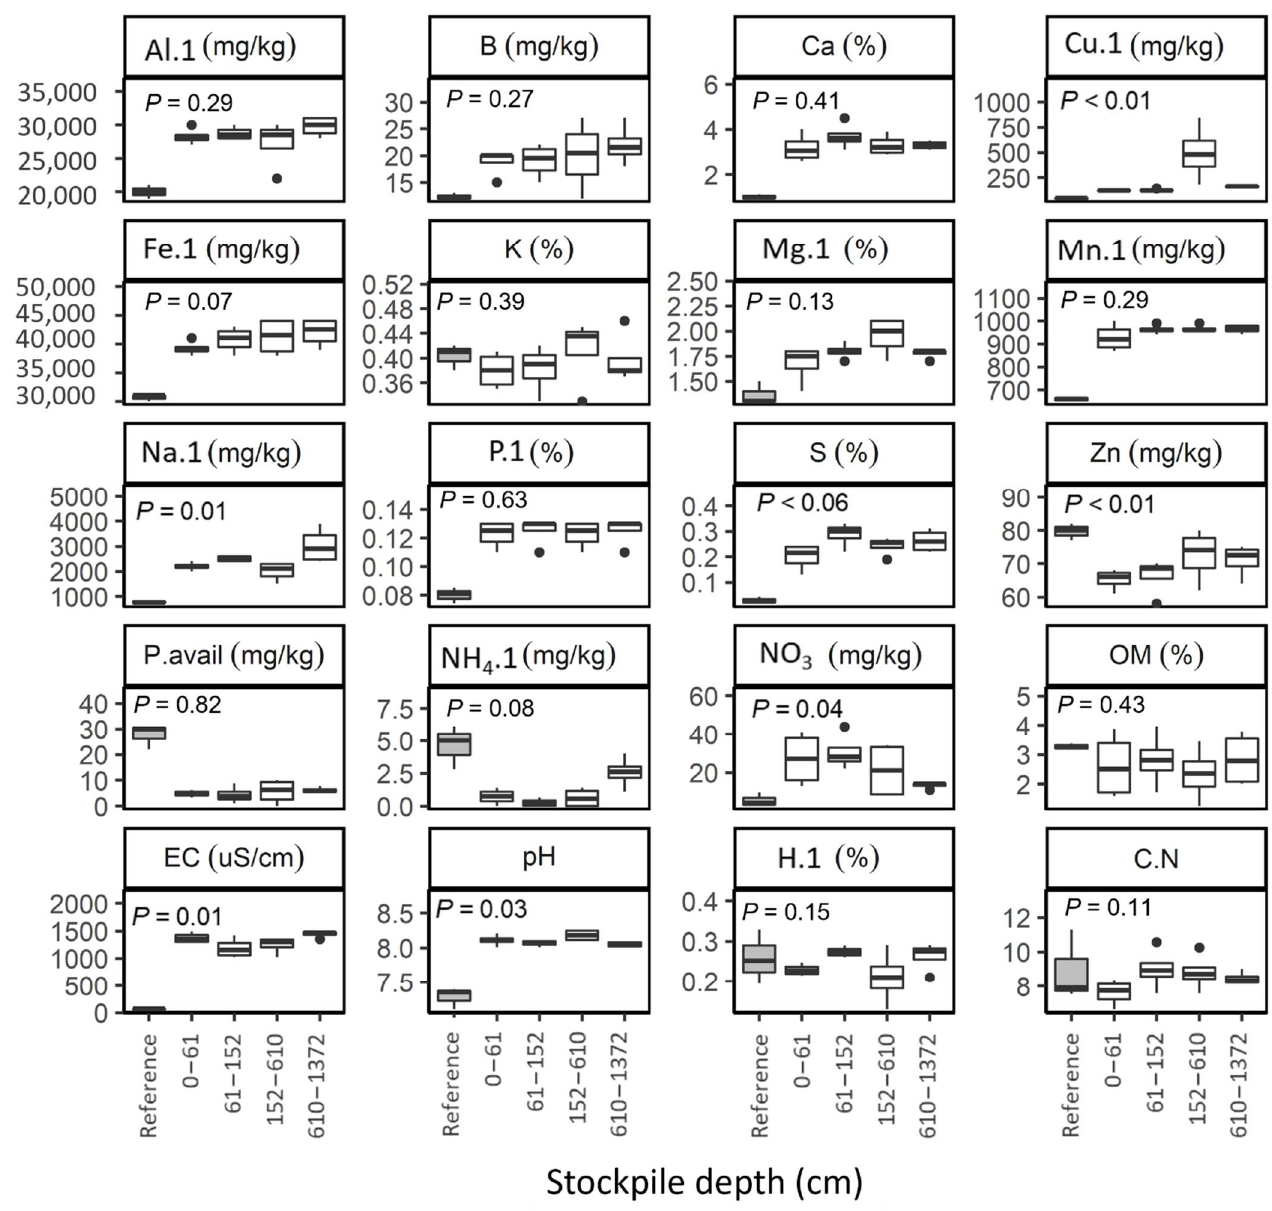
Figure 5. Boxplots showing differences in geochemical variables with stockpile depth at the New Afton site.